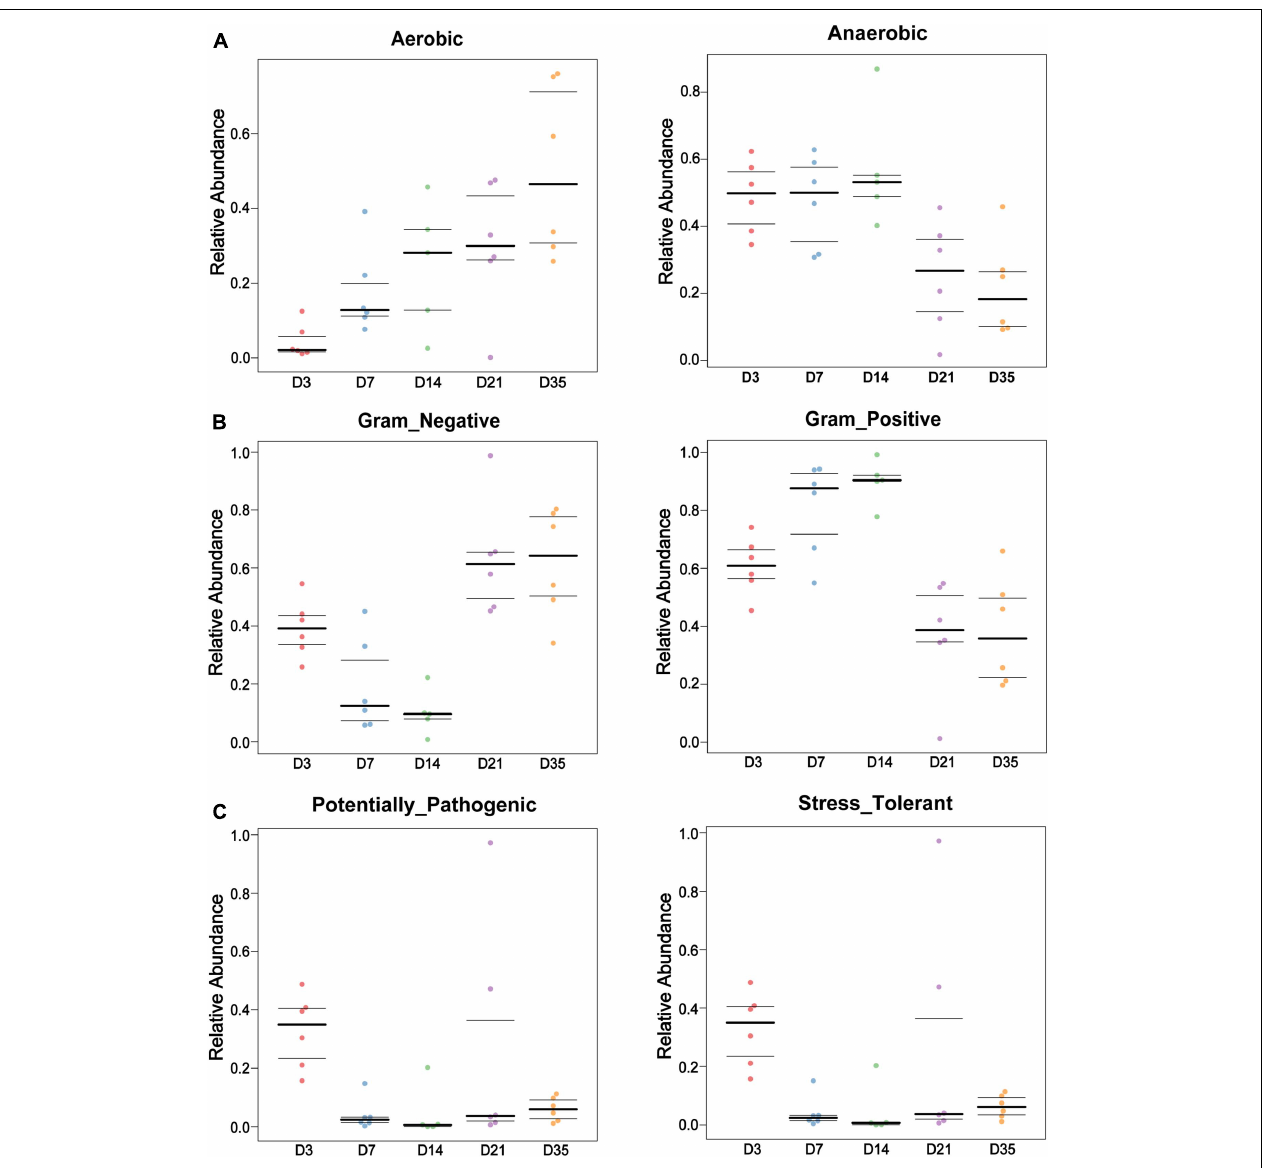
FIGURE 3 | Bacterial phenotypes changed with age. BugBase was used to analyze the lung bacterial phenotypes at different ages in this study. Bar charts showed the phenotypes as Gram-negative and Gram-positive (A) , Aerobic and Anaerobic (B) , and Potentially Pathogenic and Stress Tolerant (C) in each